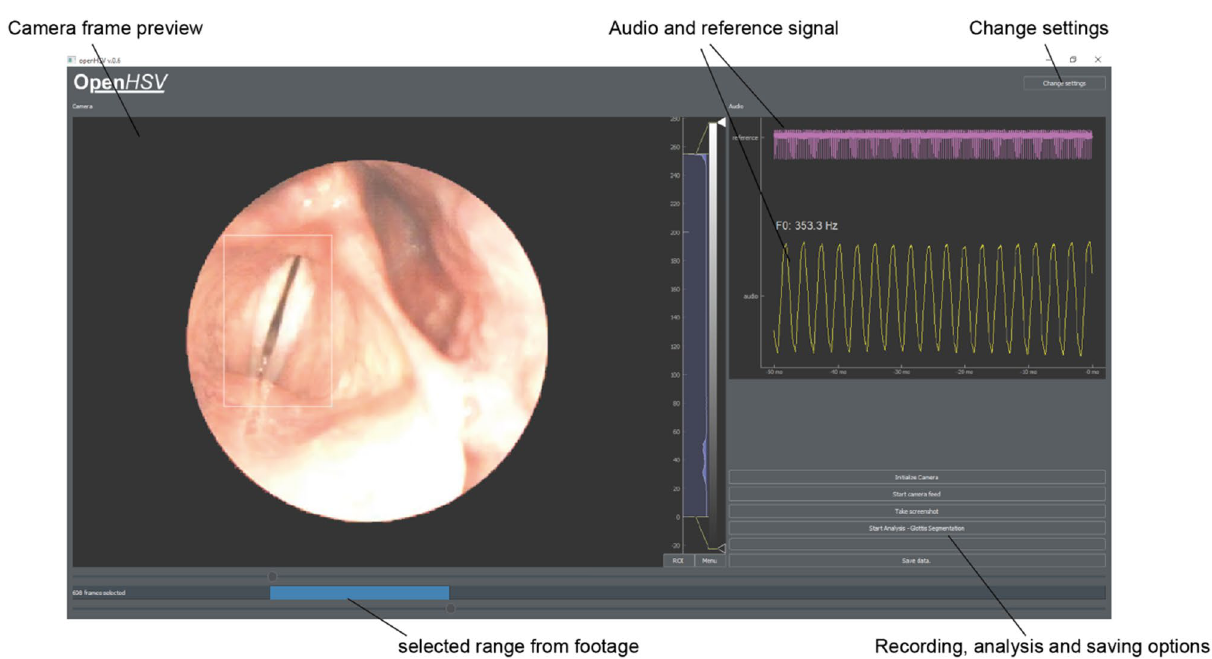
Figure 7. The OpenHSV graphical user interface. Camera image (left) and audio trace (right) are previewed online. The reference signal (pink) and the audio trace (yellow) are shown, together with the estimated fundamental frequency of the audio data. After an end-trigger (e.g. using a foot-switch), the user selects a footage range and is able to analyze and/or save the audio and video material and optionally analyzes the data